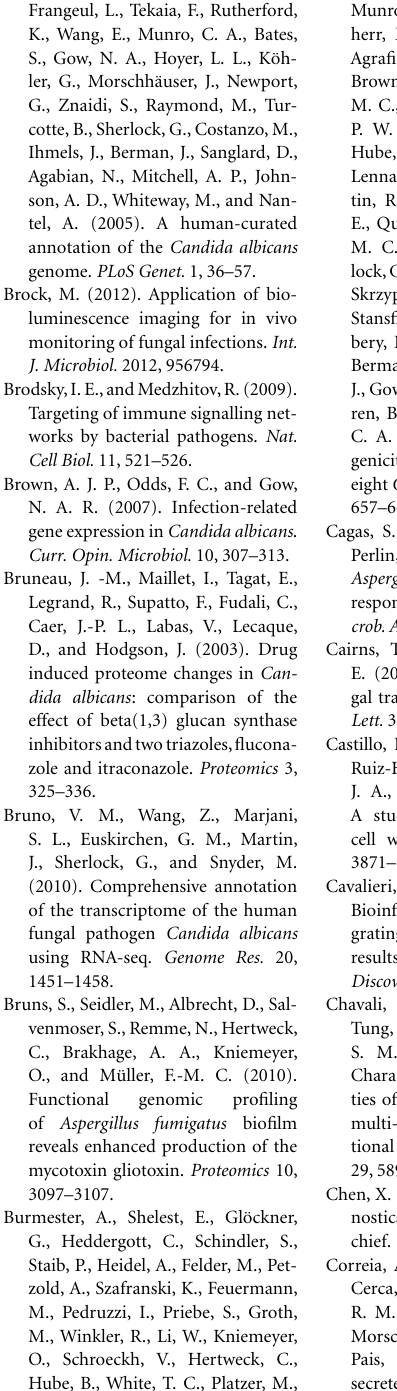
Figge, M. T., Garin, A., Gunzer, M., Kosco-Vilbois, M., Toellner, K.-M., and Meyer-Hermann, M. (2008). Deriving a germinal center